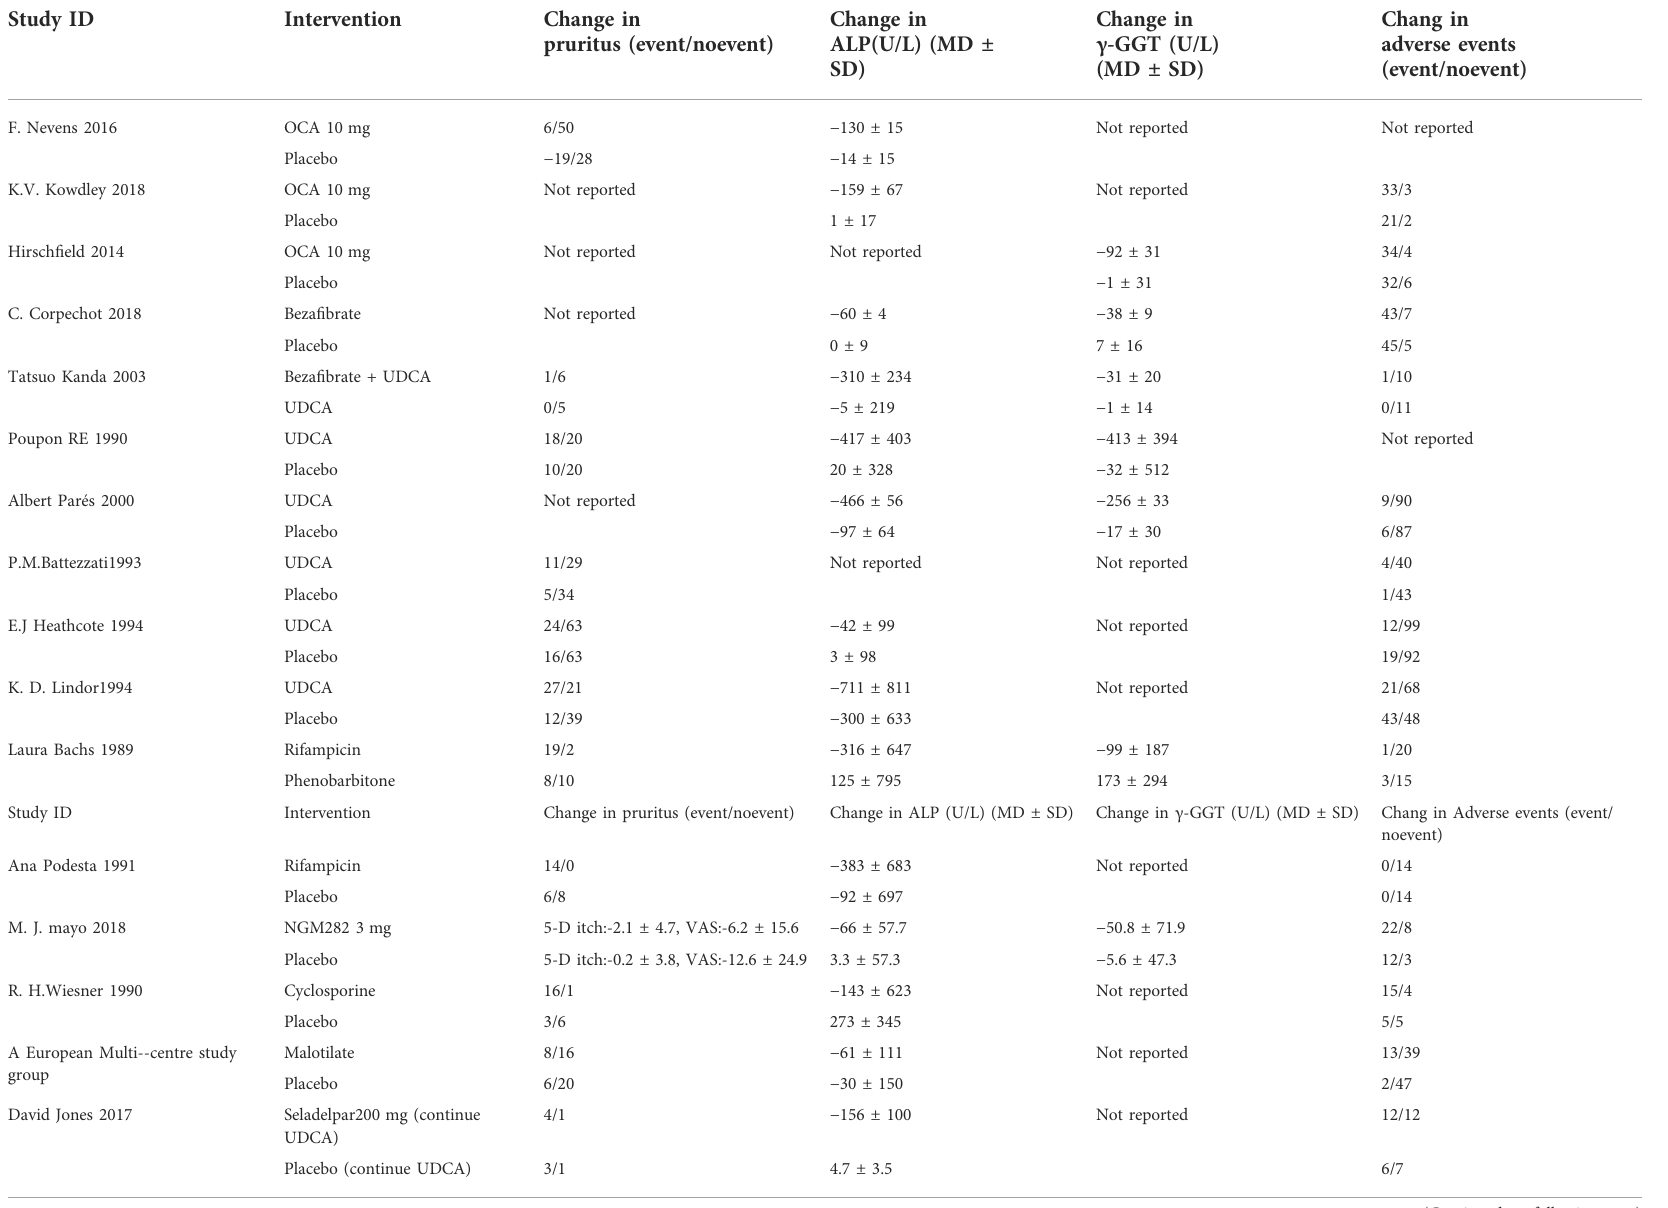
TABLE 2 Summary of results for studies were not included in the